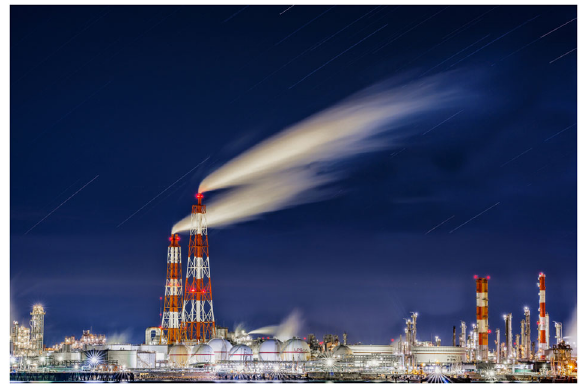
Fig. 1 An oil re fi nery at night. Onshore oil and gas is a substantial source of methane to the atmosphere. Credit: